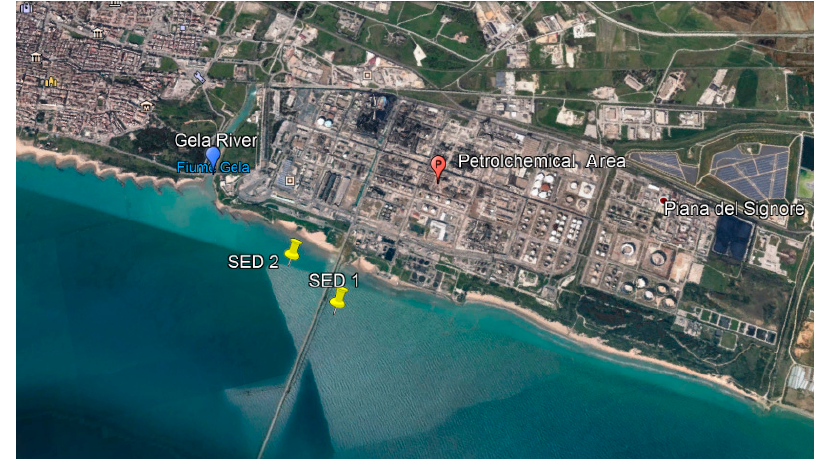
Figure 2. Sampling plan of marine sediments in the Gulf of Gela. Table 1. Sampling and physical characteristics of marine